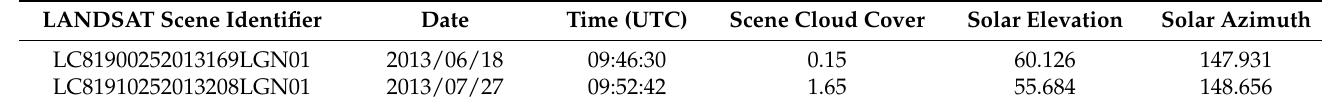
Table 2. Satellite imagery used for LST